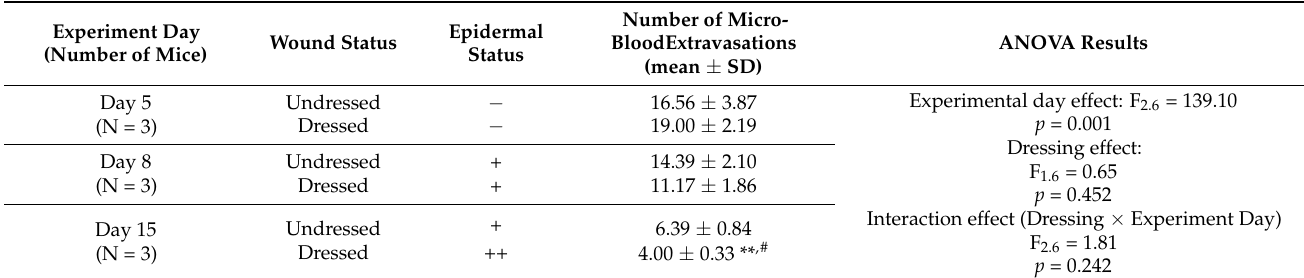
Table 2. The effect of FKDP-casomorphin dressing on the epidermis and the time course of changes in the number of microhemorrhages in full-thickness surgical skin wounds in male C57BL/6J